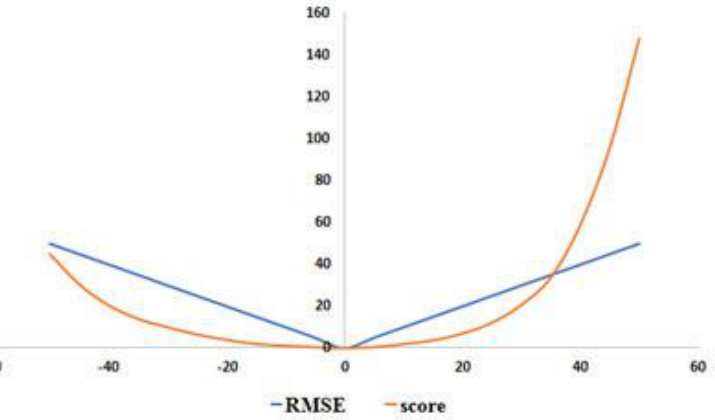
Figure 4. The curve of root mean square error (RMSE) and scoring function (SF).